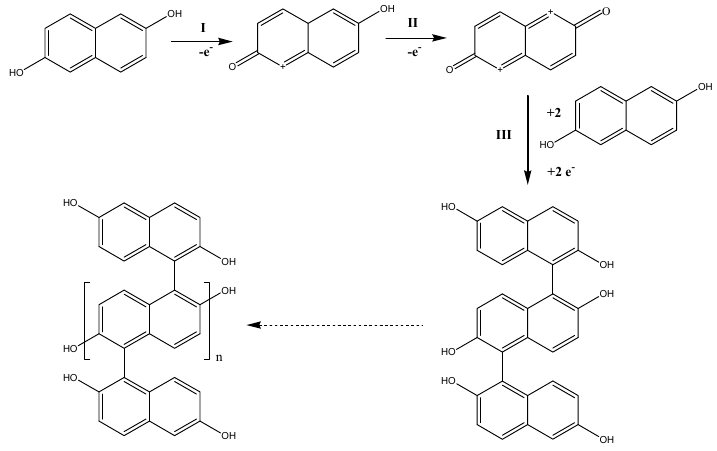
Scheme 1. Suggested electropolymerisation mechanism and structure for